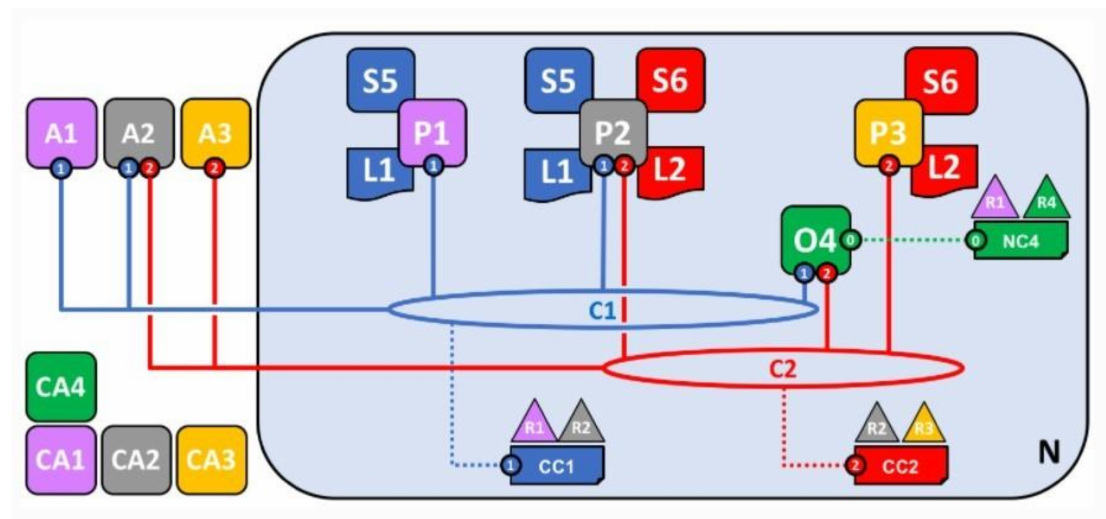
Figure 9. Hyperledger Fabric basic network architecture